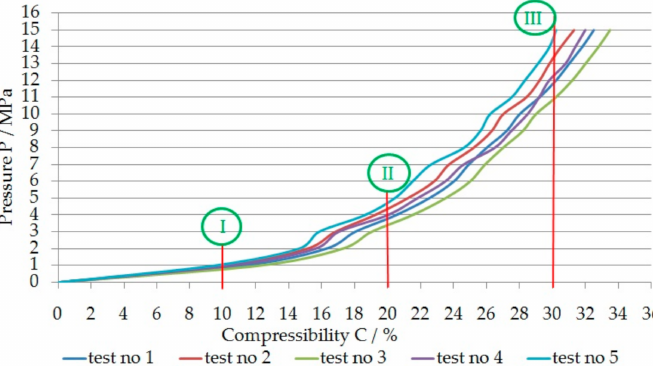
Figure 4. Gangue: ( a ) Discharge grate of mining department; ( b ) Jaw crusher with gangue; ( c ) Oedometers filled with gangue; ( d ) Laboratory test of compressibility.